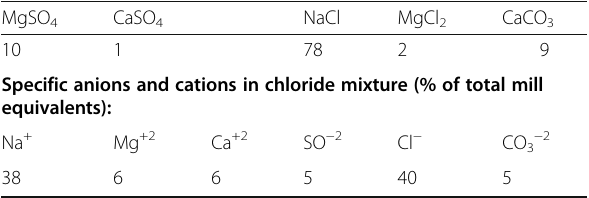
Table 1 Salt mixture components for the used chloride salinization (expressed as percentage of total salt content)